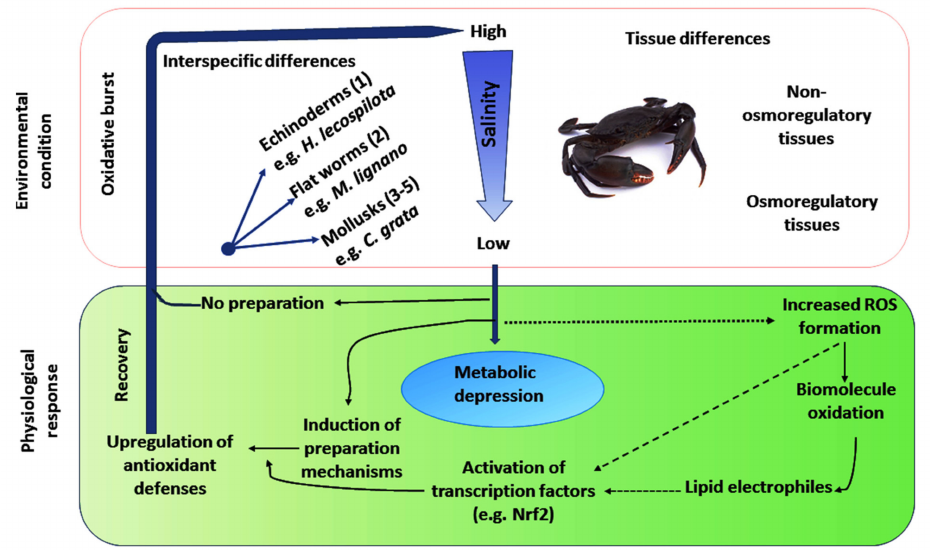
Figure 8. Redox-regulatory responses in different phyla under salinity stress: Different organisms have comparatively different adaptive mechanisms to control bodily osmotic pressure. The final osmotic tissue pressure under low or high salinity invariably leads to high reactive oxygen species in all lower invertebrates, including mollusks, worms, and echinoderms. NrF2 signaling to sense the high ROS-induced redox regulation via antioxidant enzyme expression may be able to control the reactive oxygen species and oxidative stress, and other animals may undergo low metabolic adaptations such as metabolic depression that can help the animals to produce low amounts of reactive oxygen species and achieve high rates of survival under salinity